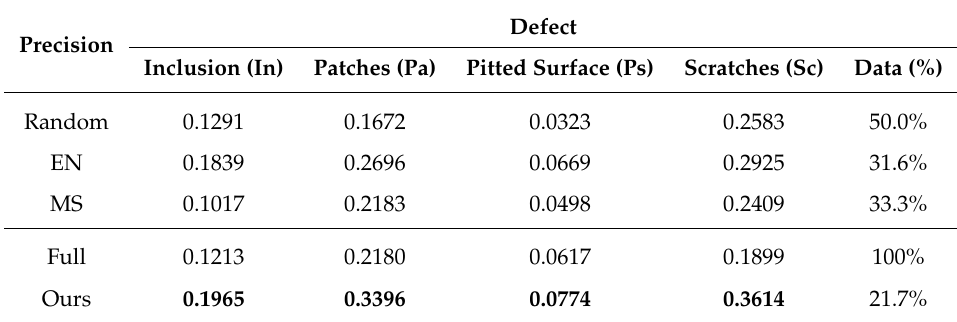
Table 2. Comparison of Precision on the NEU-DET dataset. The best results are shown in boldface.